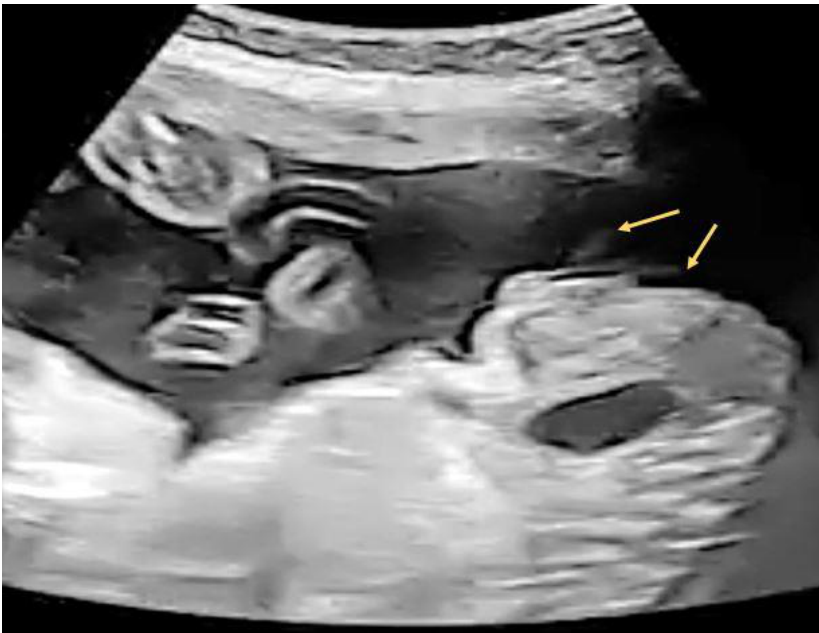
Figure 8. Split jet of urinary stream (arrows) seen after external provocation under gray scale.